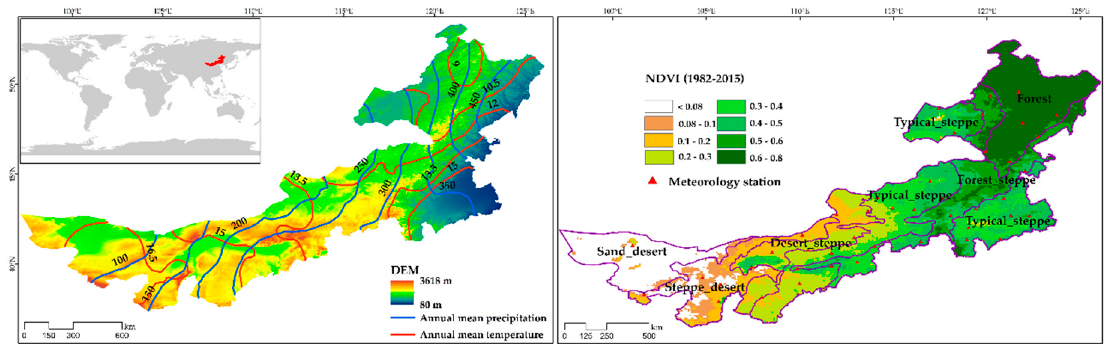
Figure 1. Spatial distribution of annual precipitation and mean temperature ( left ), and different vegetation types and mean normalized difference vegetation index (NDVI) in Inner Mongolia during 1982–2015 ( right ).